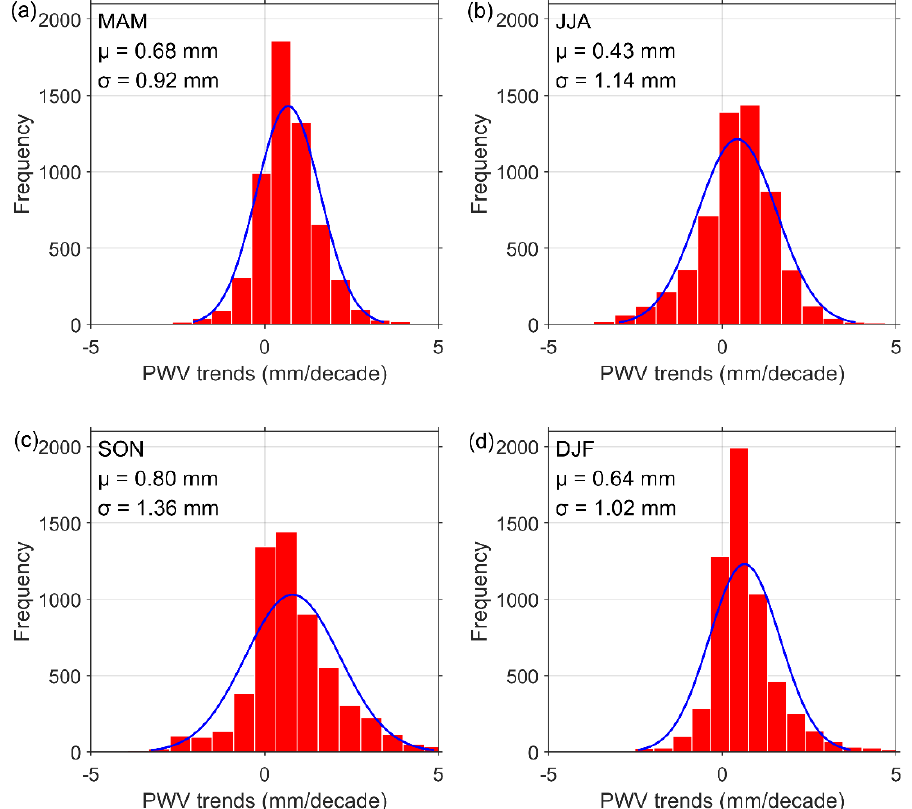
Figure 10. Seasonal frequency histograms of PWV trends during 1994–2020 for ( a ) MAM, ( b ) JJA, ( c ) SON, and ( d ) DJF.